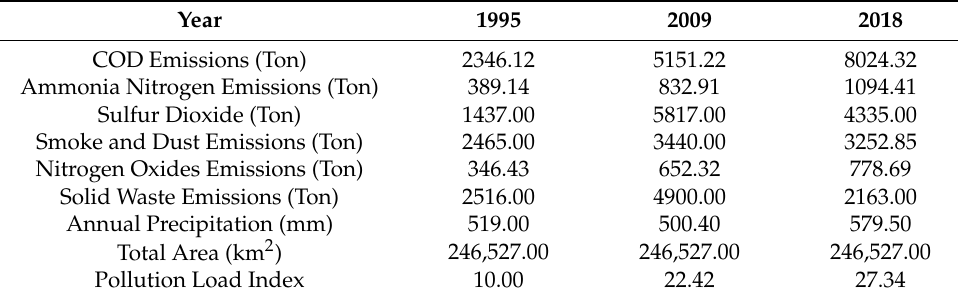
Table 9. Results of the pollution load index in Hetian.